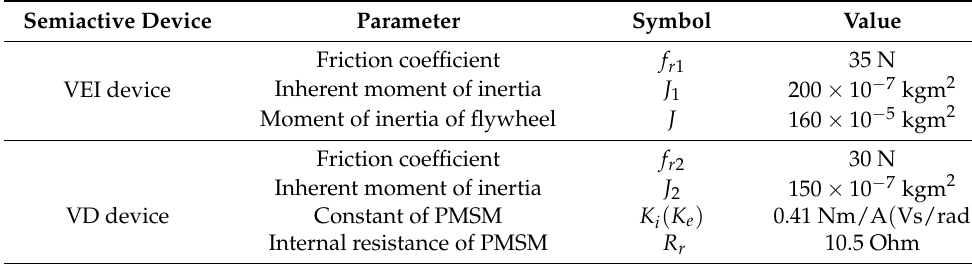
Table 1. Parameters of the VEI–VD